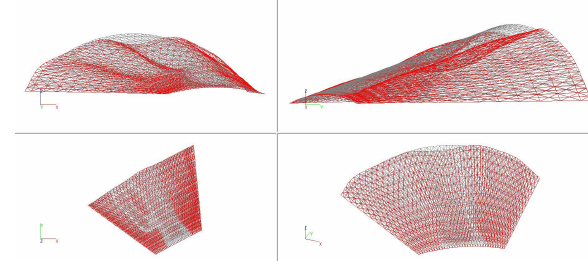
Figure 13: The deformation scheme of conoid